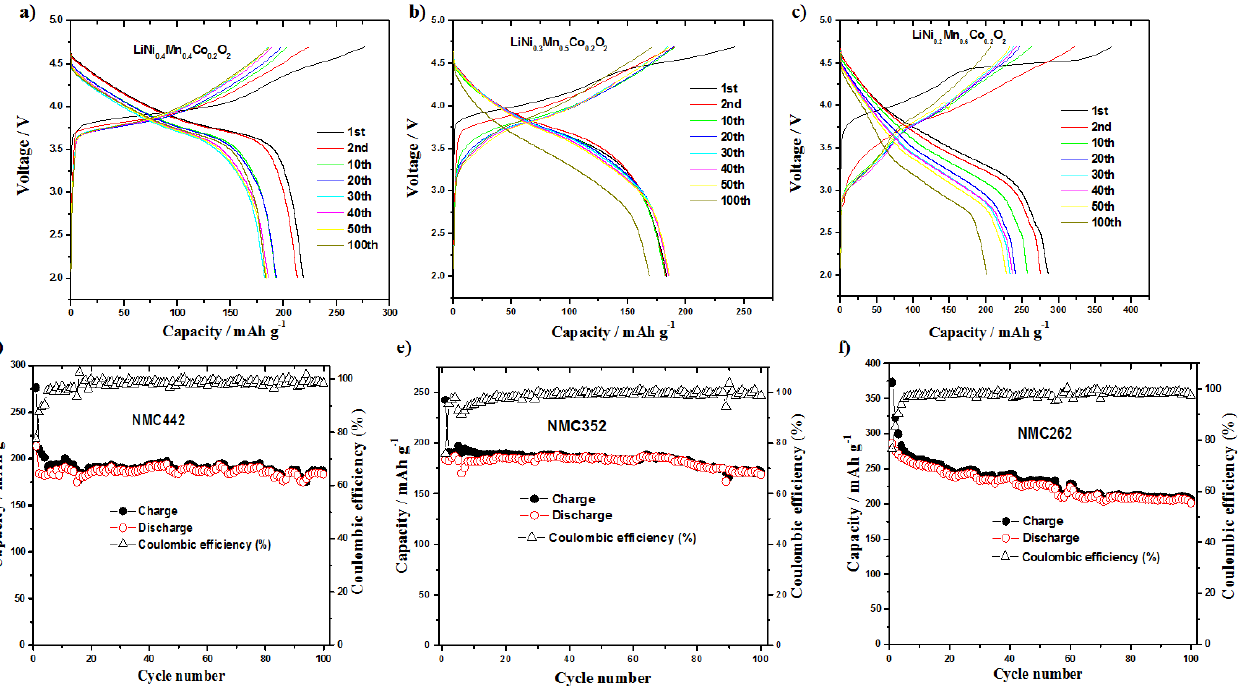
Figure 4. ( a – c ) Charge–discharge curves for NMC442, NMC352 and NMC262 at a current rate of 20 mA g − 1 for the voltage range of 4.7–2.0 V. ( d – f ) Capacities versus cycle number of NMC442, NMC352